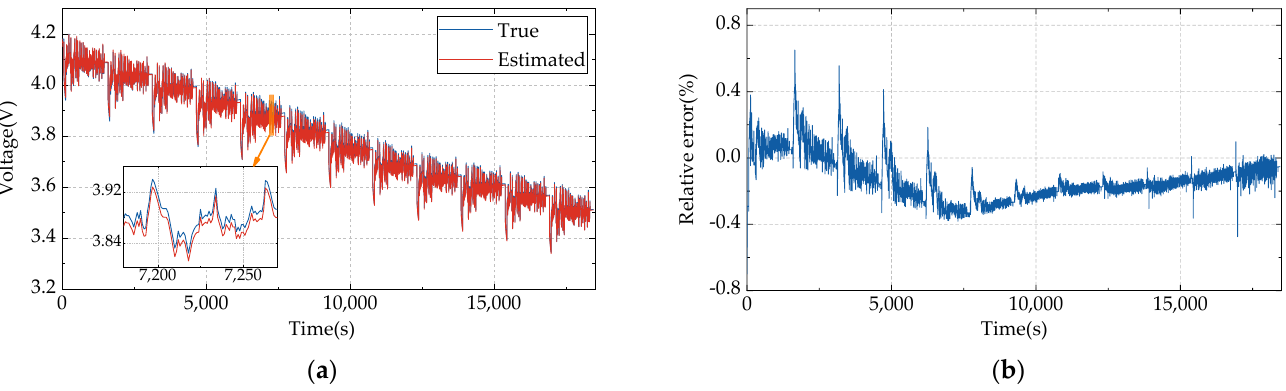
Figure 10. Terminal voltage response and relative error of FFRLS parameter identification under UDDS condition: ( a ) estimated terminal voltage; ( b ) corresponding error of terminal voltage estimation.